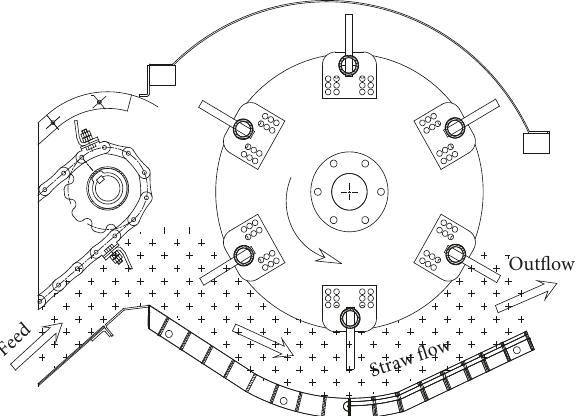
Figure 1: Rice straw flow and eccentric load in tangential threshing process.